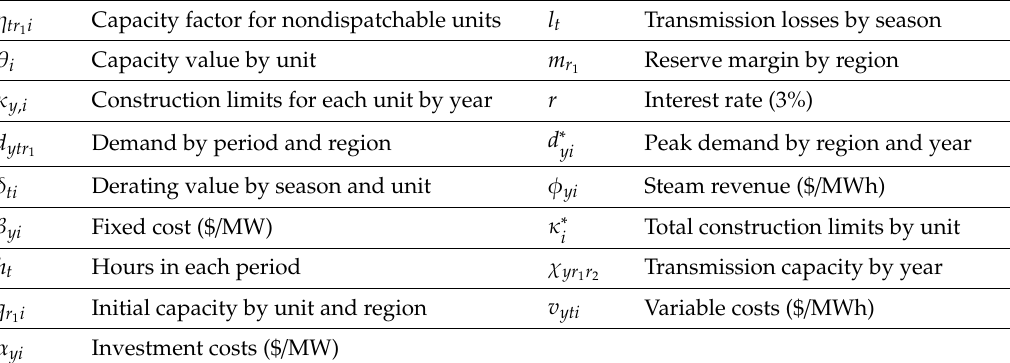
Table 2. GEP Model Parameter Definitions